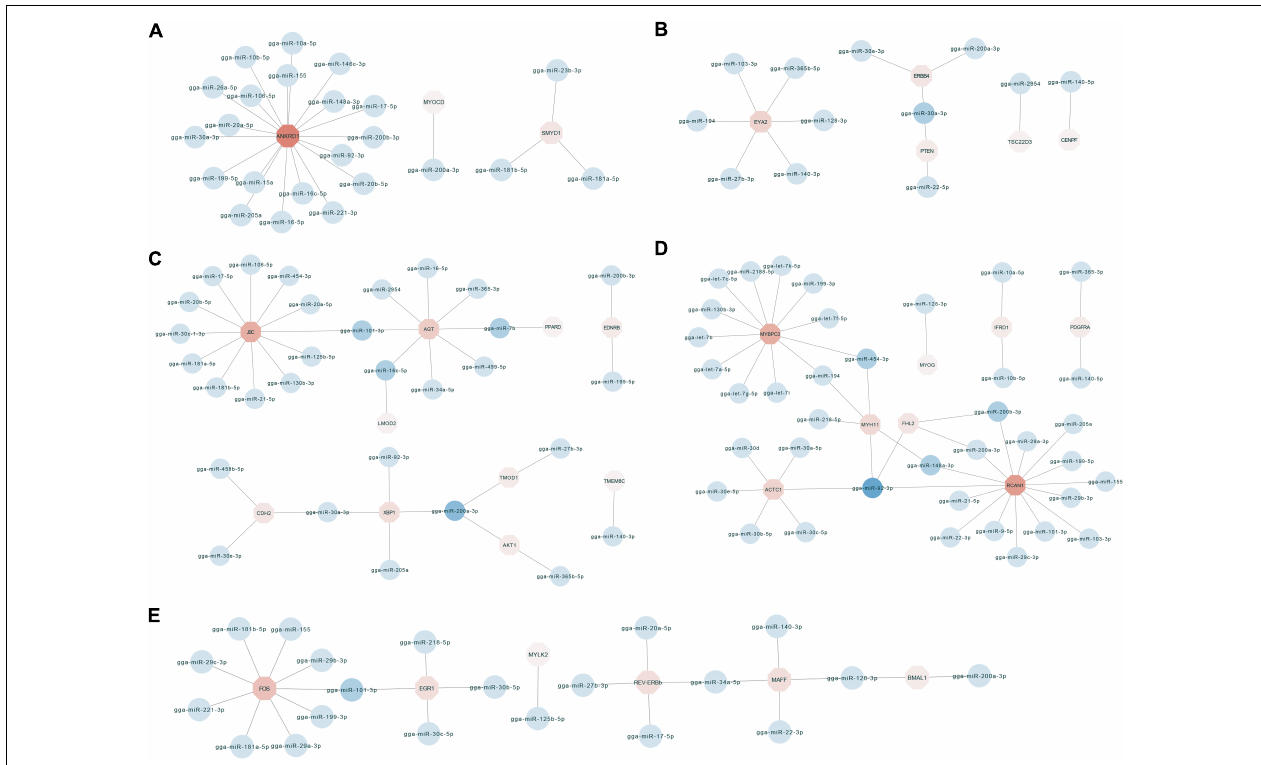
FIGURE 3 | The miRNA–mRNA interaction network related to biological process including muscle cell differentiation, striated muscle tissue development and skeletal muscle cell differentiation. (A) The miRNA–mRNA pairs with ANKRD1 as the core. (B) The miRNA–mRNA pairs with EYA2 as the core. (C) The miRNA–mRNA pairs with JSC and AGT as the core. (D) The miRNA–mRNA pairs with MYBPC3 and RCAN1 as the core. (E) The miRNA–mRNA pairs with FOS as the